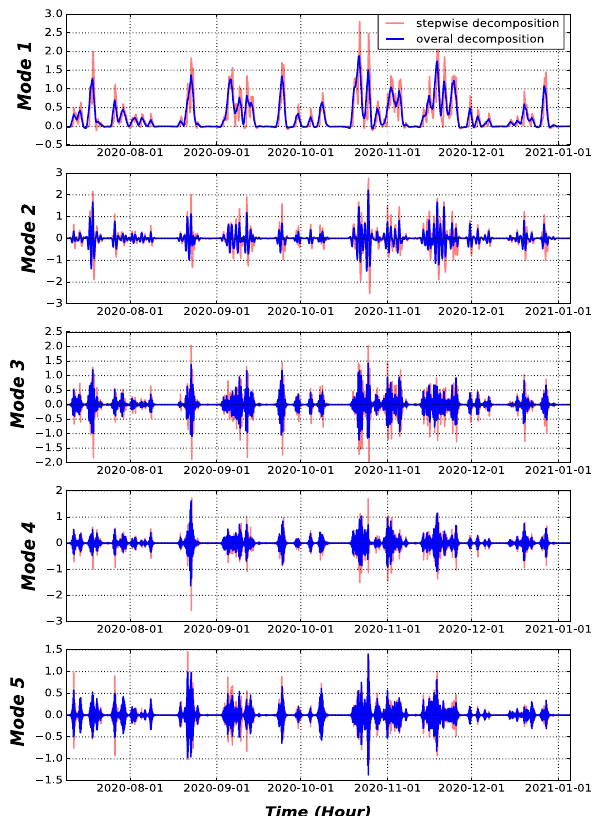
Figure 7. Comparison of VMD decomposition by using the step-wise mechanism or overall-decomposition mechanism on validation and test